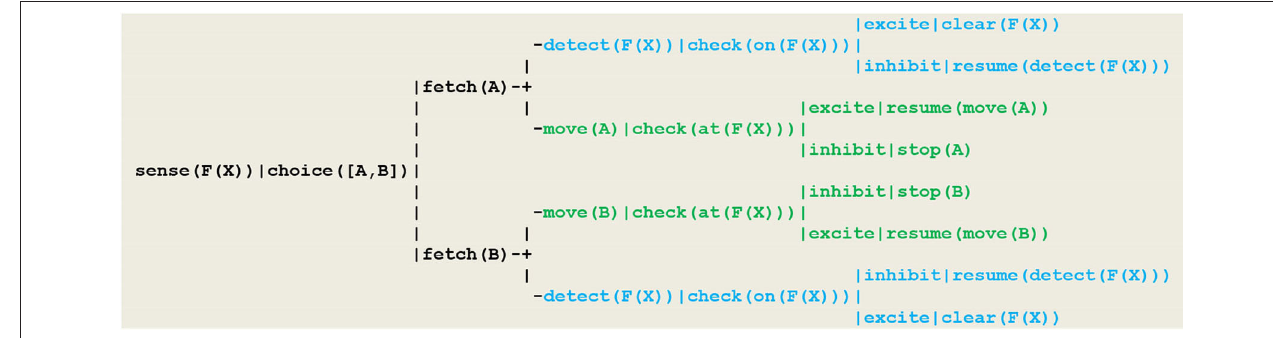
FIGURE 9 | Circuit implementing a random detector. In this circuit, (1) detecting the smoke of a fire at location F(X) is implemented by the thread sense(F(X)) , (2) the random choice between two gears A or B follows from the execution of the virtual machine instruction choice([A,B]) that produces an internal fetch stimulus, (3) detecting the fire proceeds through the thread detect(F(X)) , with the execution of the virtual machine instruction check(on(F(X))) producing an excite internal stimulus if the vehicle did hit the fire (in which case he will clear the fire) or an inhibit internal stimulus (in which case he will resume detecting) (4) moving is achieved through the move(A) or move(B) threads; depending on whether or not the current vehicle position F(X) is defined, the execution of the virtual machine instruction check(at(F(X))) similarly produces an internal excite (in which case he will resume moving) or an inhibit stimulus indicating that he has reached the track limit and must stop .